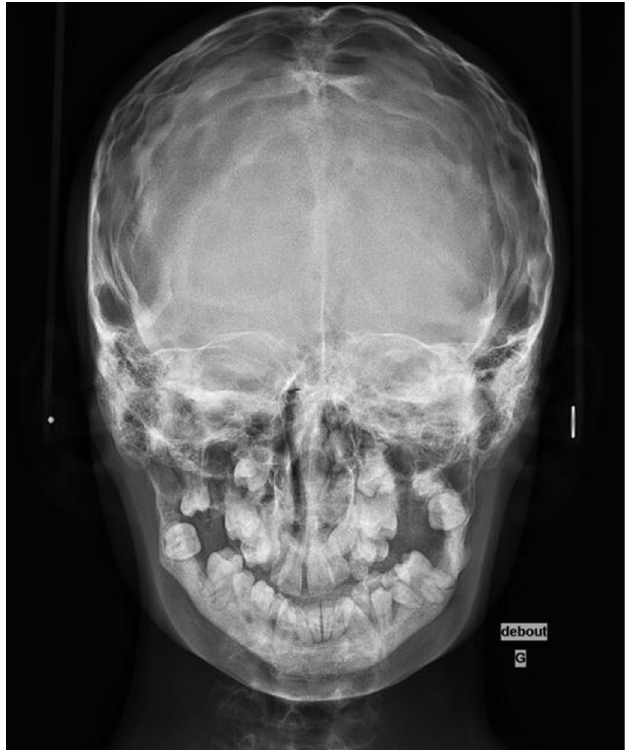
Fig. 3. Frontal teleradiograph.